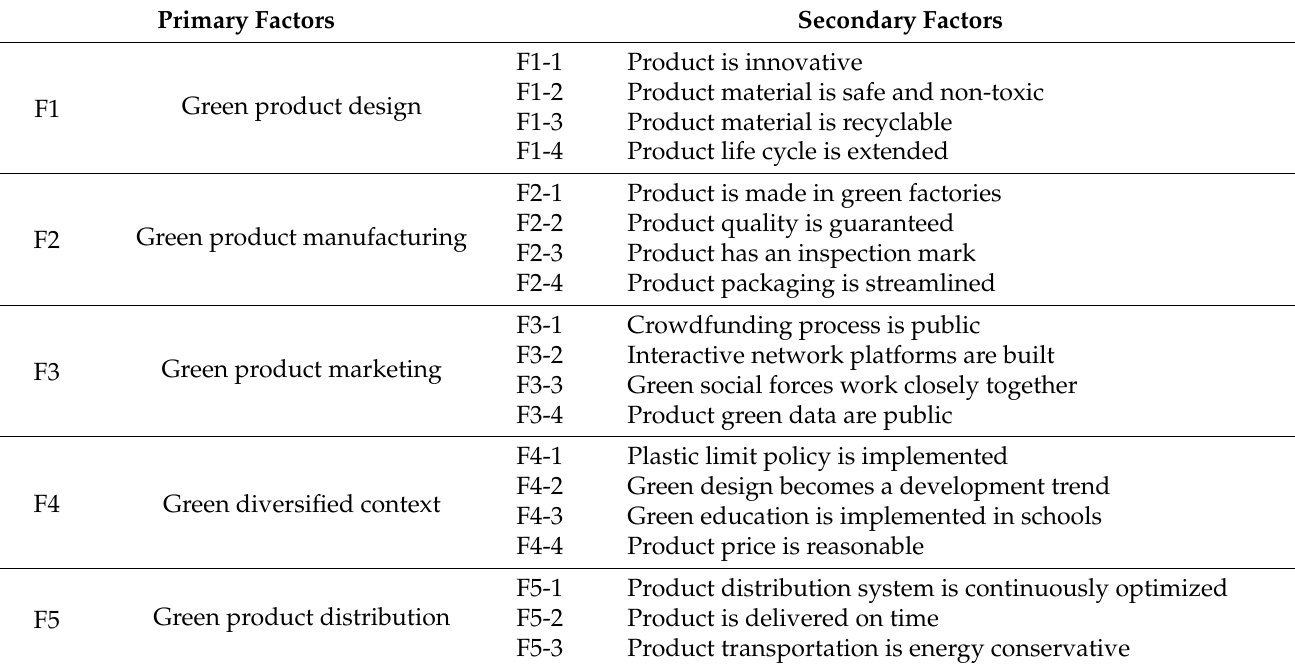
Table 6. Construct and contents of factor